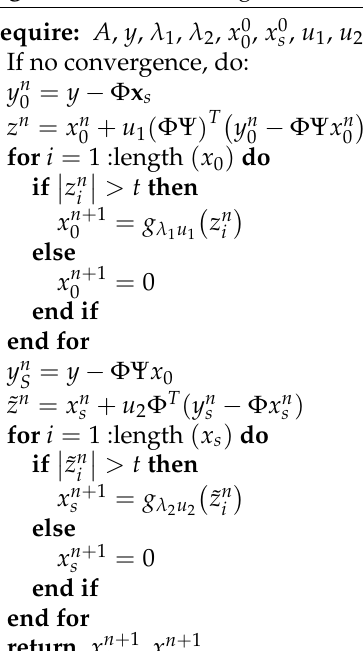
Algorithm 1 Alternating direction iteration fraction penalty thresholding